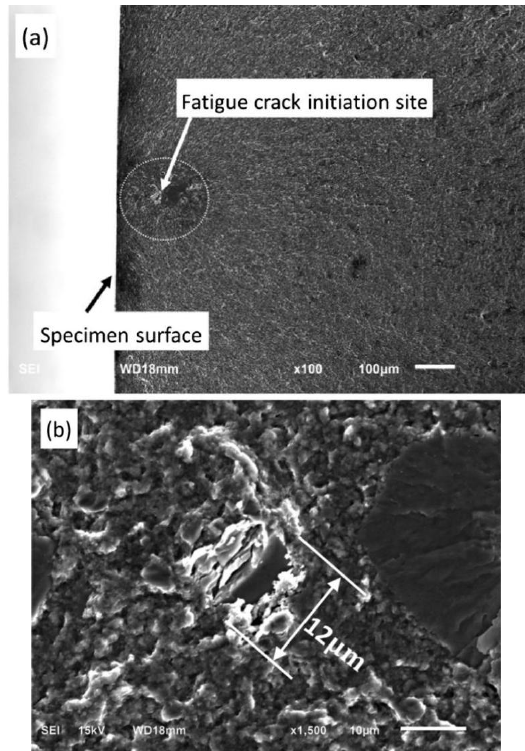
Figure 4. Magnification of crack initiation position (a) The crack location with whole morphology; (b) detail of the crack initiation site [23].